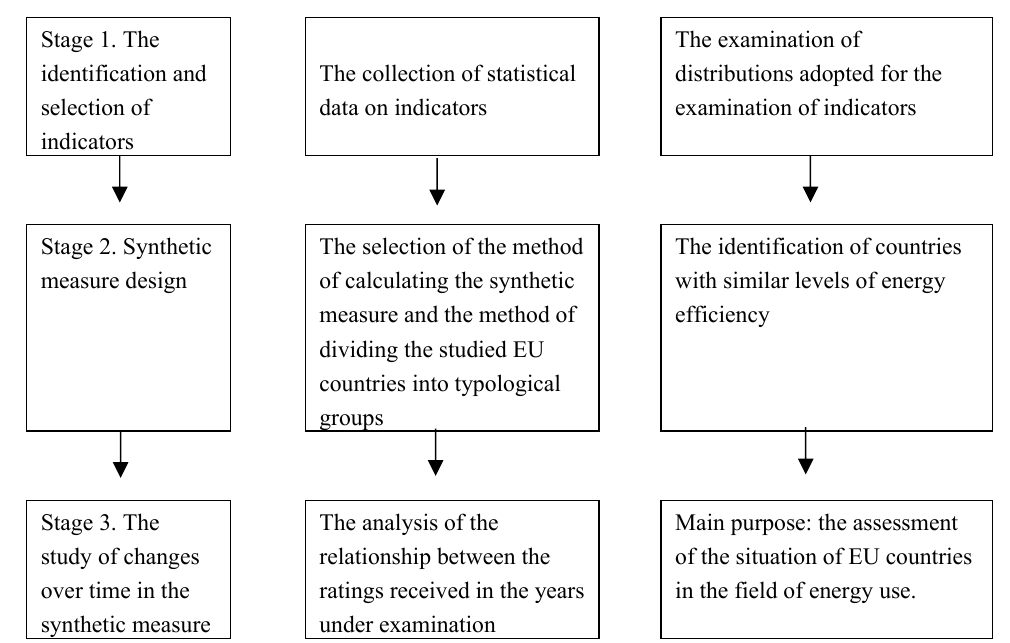
Figure 2. Research procedure chart.